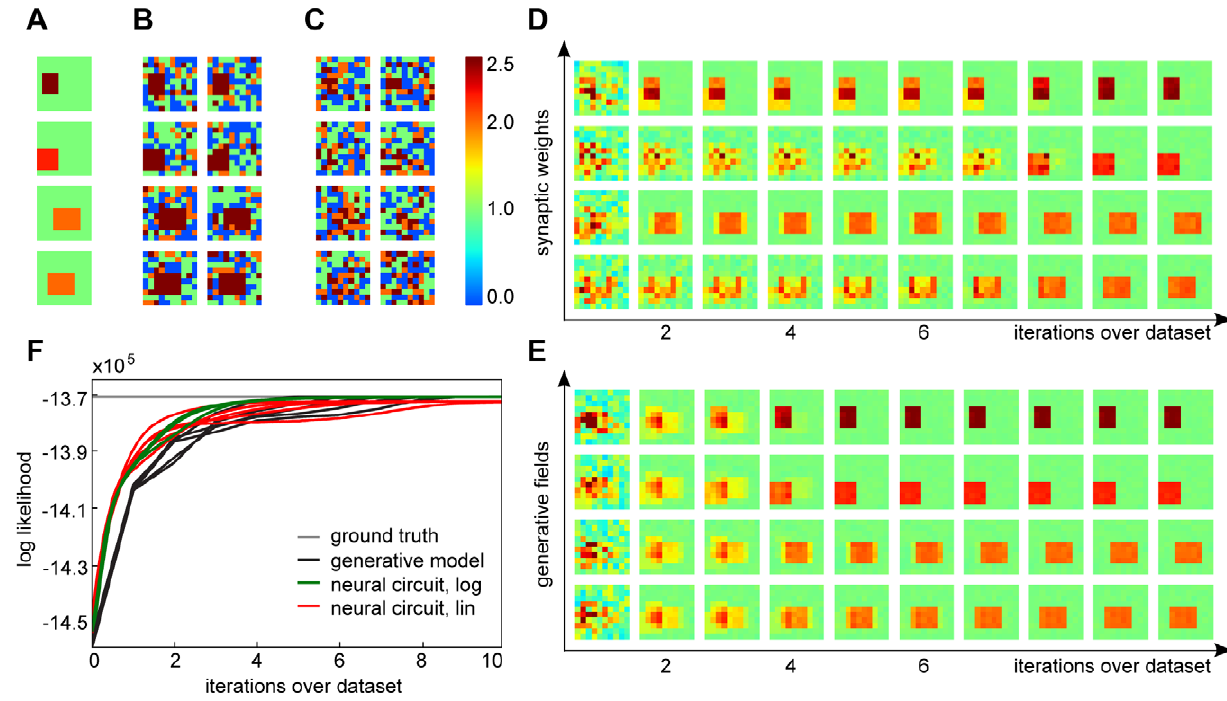
Figure 2. Learning on artificial data. (A) An example set of generative fields W gen , for D ~ 100 ( 10 | 10 pixels). Due to the normalization, different rectangles have different pixel intensities (displayed here for A ~ 120 ). (B) Some examples of generated data for the same rectangles as in (A) with normalization constants A ~ 240 . (C) Same examples with A ~ 120 . Very high intensity values were truncated to improve visibility. (D) The evolution of synaptic weights during learning in the neural circuit (linear case) if data as in (C) was used. (E) Evolution of the generative fields using EM algorithm for the same data. (F) Likelihood changes during learning for the neural circuit (both versions) and EM; learning used 10000 inputs from the classes shown in (A) with A ~ 120 . Different lines of the same color mark individual runs with different random initial conditions.